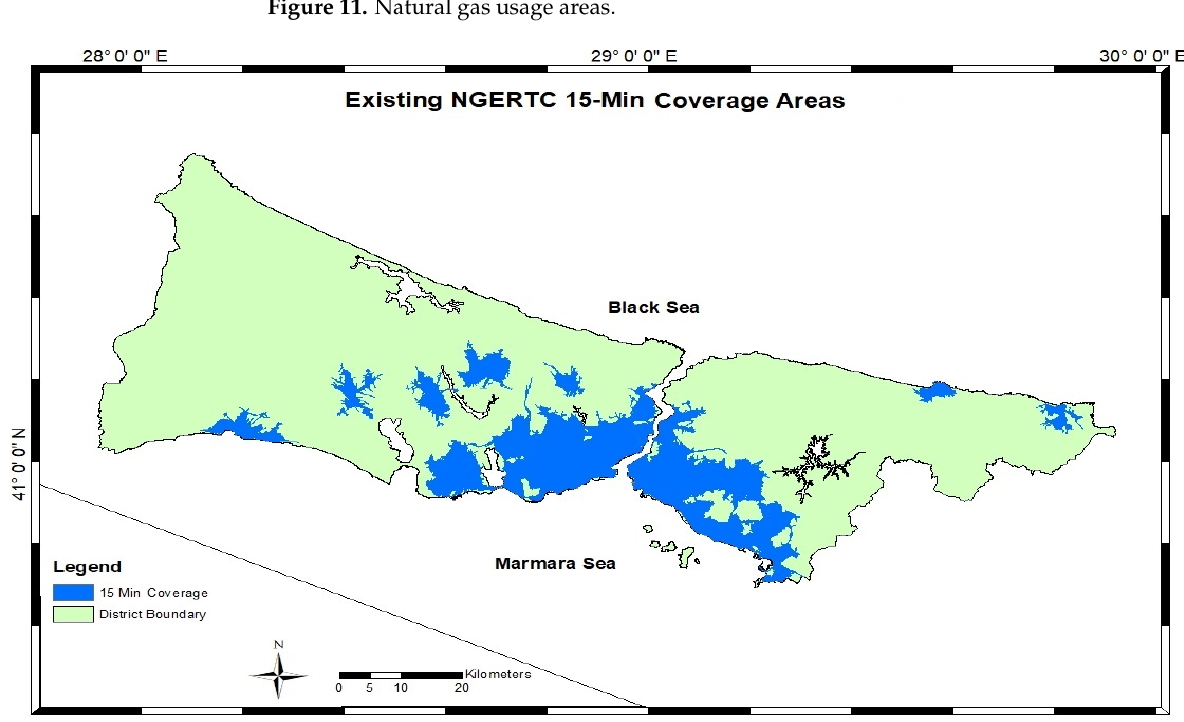
ISPRS Int. J. Geo ‐ Inf. 2022 , 11 , x FOR PEER REVIEW